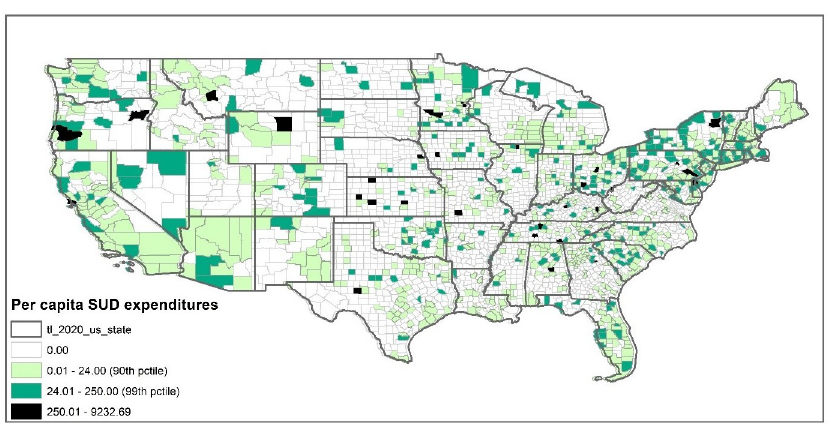
Fig 1. County-level distribution of nonprofit SUD facilities’ expenditure per